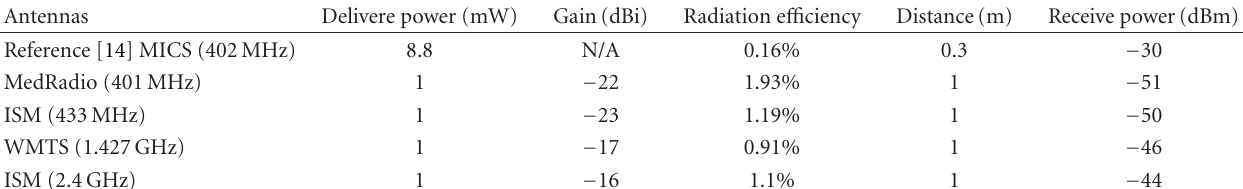
Table 3: Comparison of the measured received power between the proposed antenna and [14].